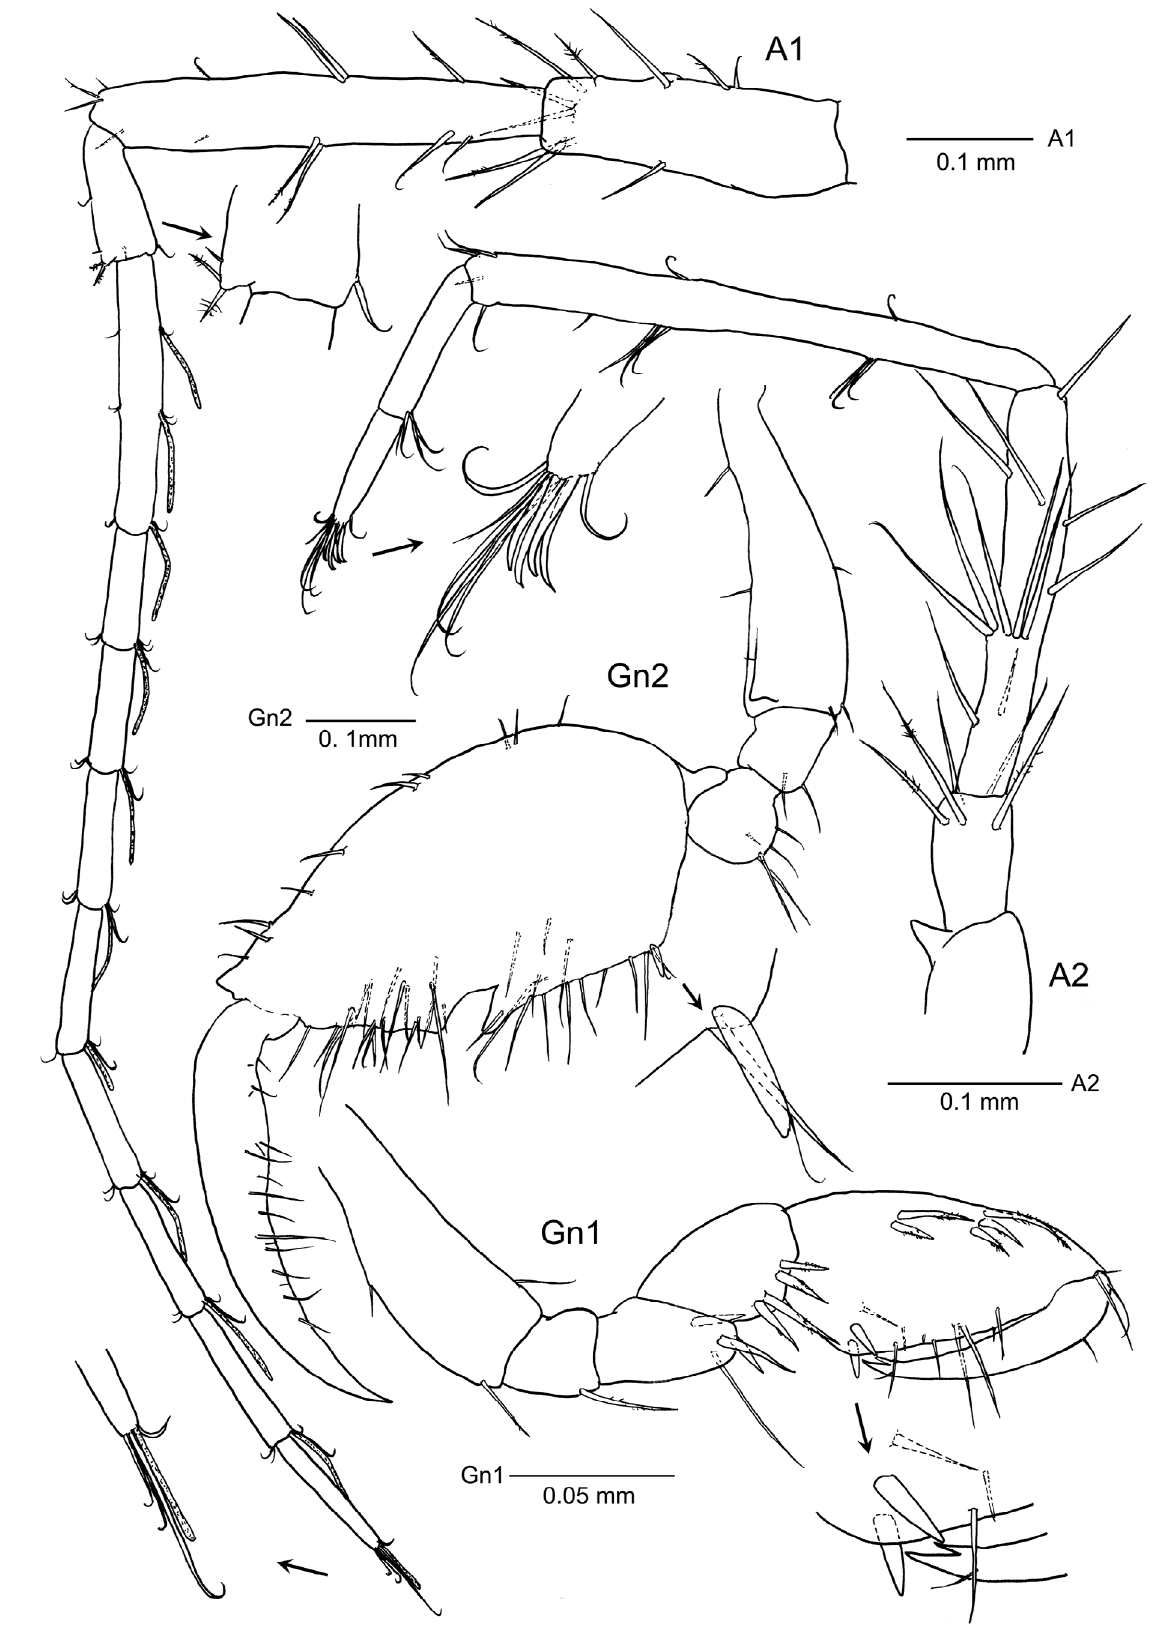
Figure 4. Parapseudaeginella australiensis n. sp. Antennae and gnathopod 1 of holotype male (WAM C76110). Gnathopod 2 of paratype male (AM P.101304). Abbreviations: A1, 2 = Antenna 1, 2; Gn 1, 2 = Gnathopod 1,